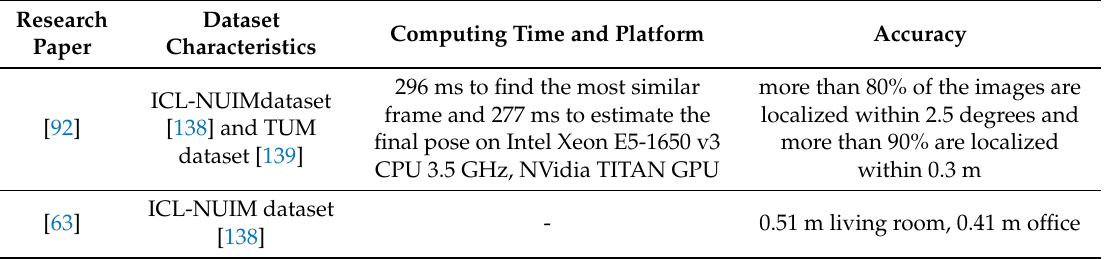
Table 10. Characteristics of indoor localization solutions with real image/feature databases, 3D mobile cameras, and artificial